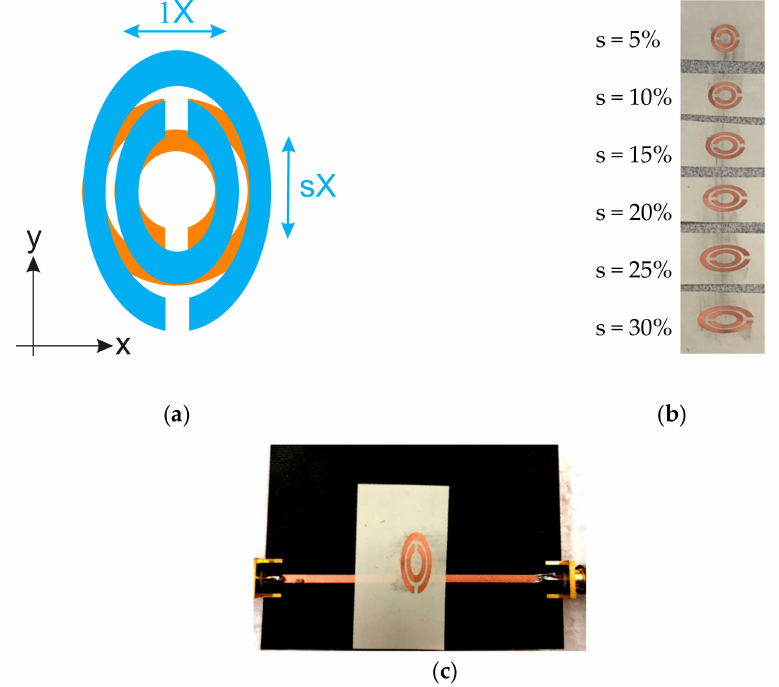
Figure 13. ( a ) Schematic of scaling concept, ( b ) fabricated scaled dynamic DSRRs ranging from 5–30 %, ( c ) measuring scaled DSRR as stretched.